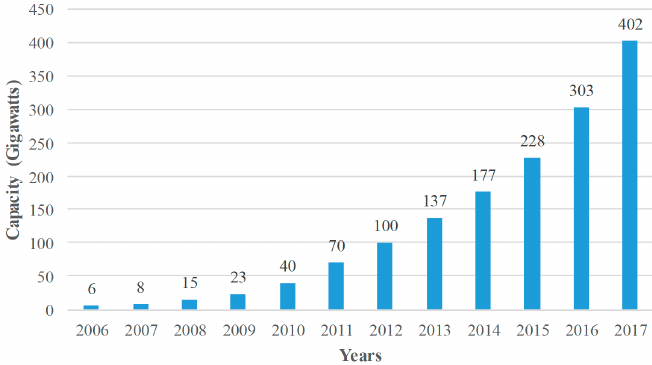
Figure 1. Installed global solar photovoltaic (PV) capacity (2006 to 2017) [11] .